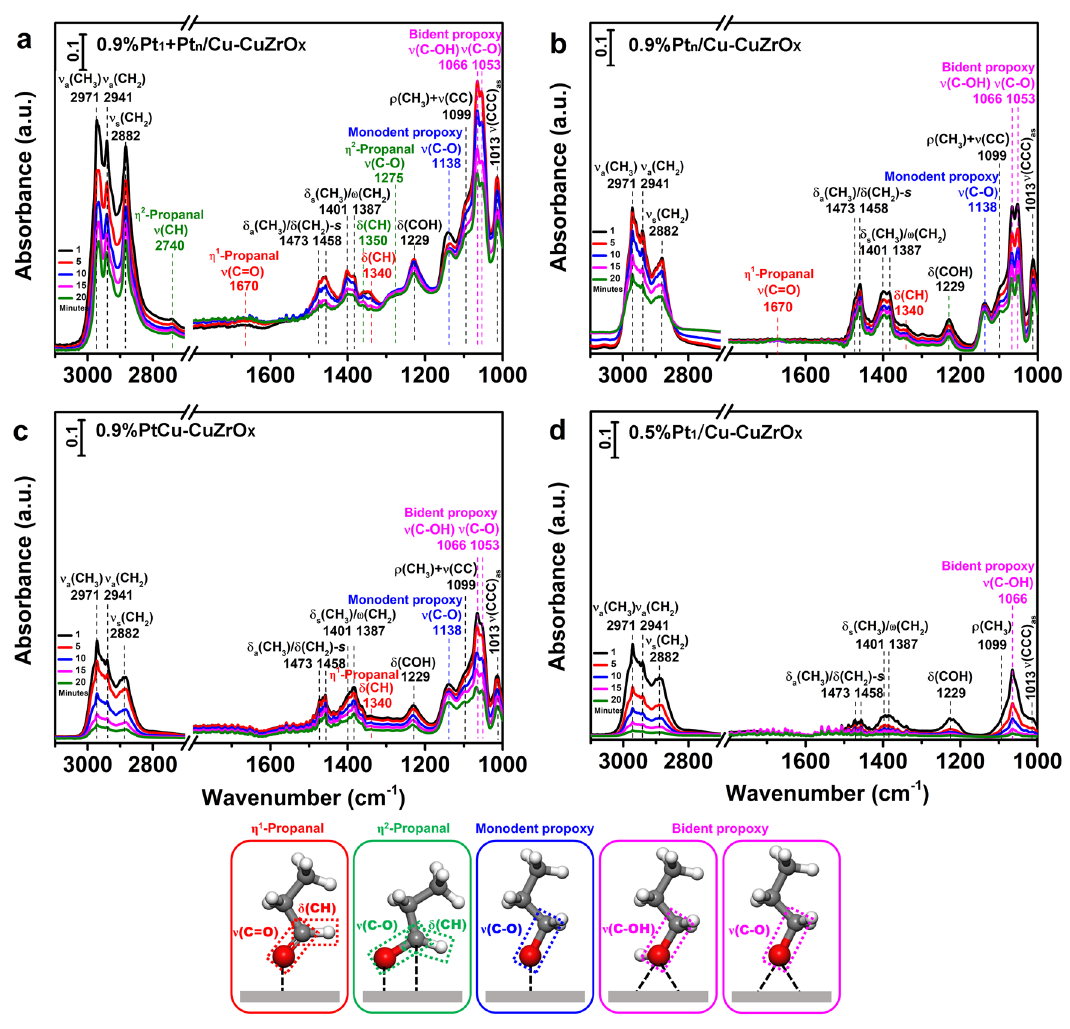
Fig. 4 | The activation of the primary O-H and C-H bonds. In situ FT-IR spectra aftertheadsorptionof1-propanolfor30minfollowedbydesorptionatdesorption timesof1,5,10,15,and20min(fromtoptobottom)on0.9%Pt 1 +Pt n /Cu-CuZrO x ( a ),